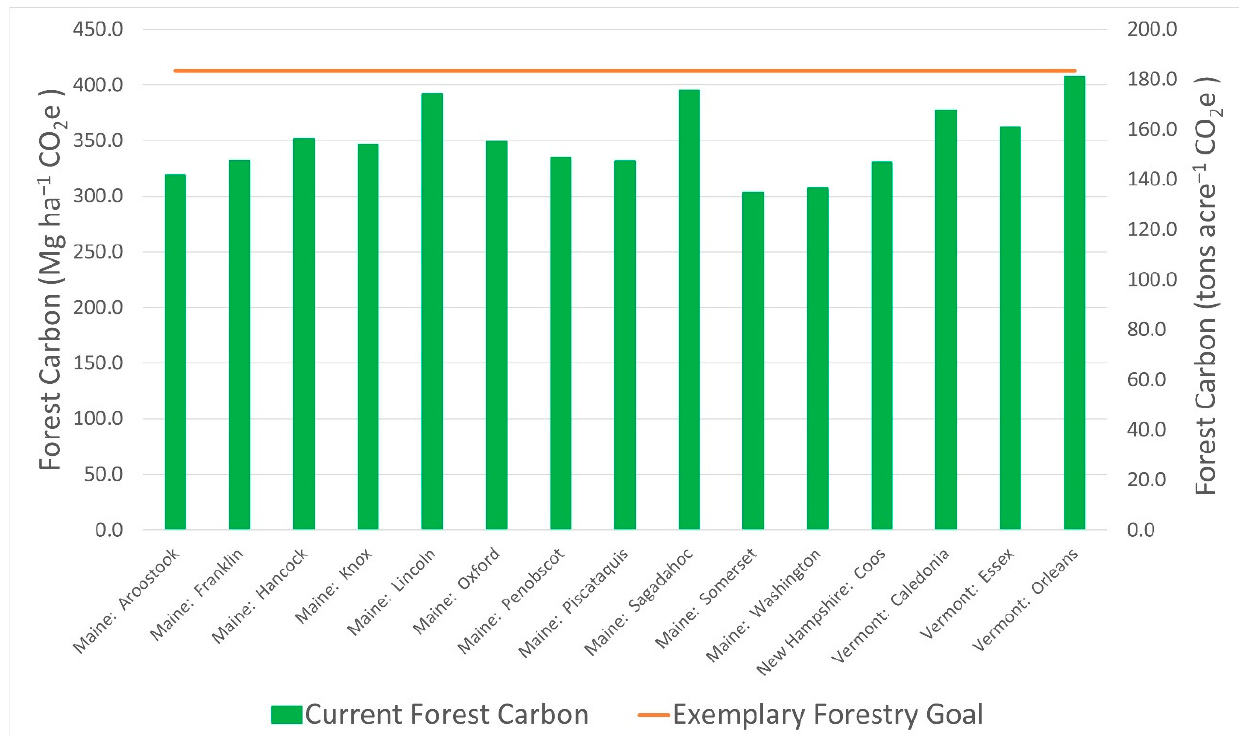
Figure 7. Carbon storage per hectare on privately owned timberland in the Acadian Forest of New England in counties with average carbon storage below 413 Mg ha − 1 CO 2 e. The gap between carbon storage at present (green bars) and the expected storage under EF management (orange line) is the average carbon storage opportunity per hectare.